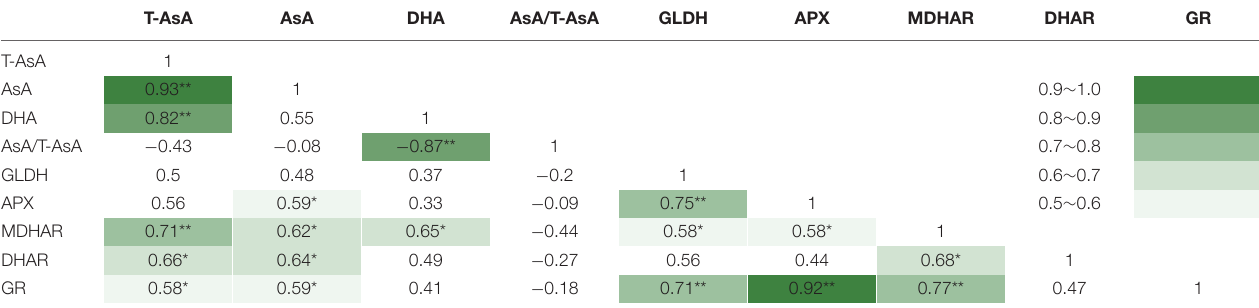
Correlation was significant at *p < 0.05; **p < 0.01. The deeper the color is, the greater the correlation coefficient.